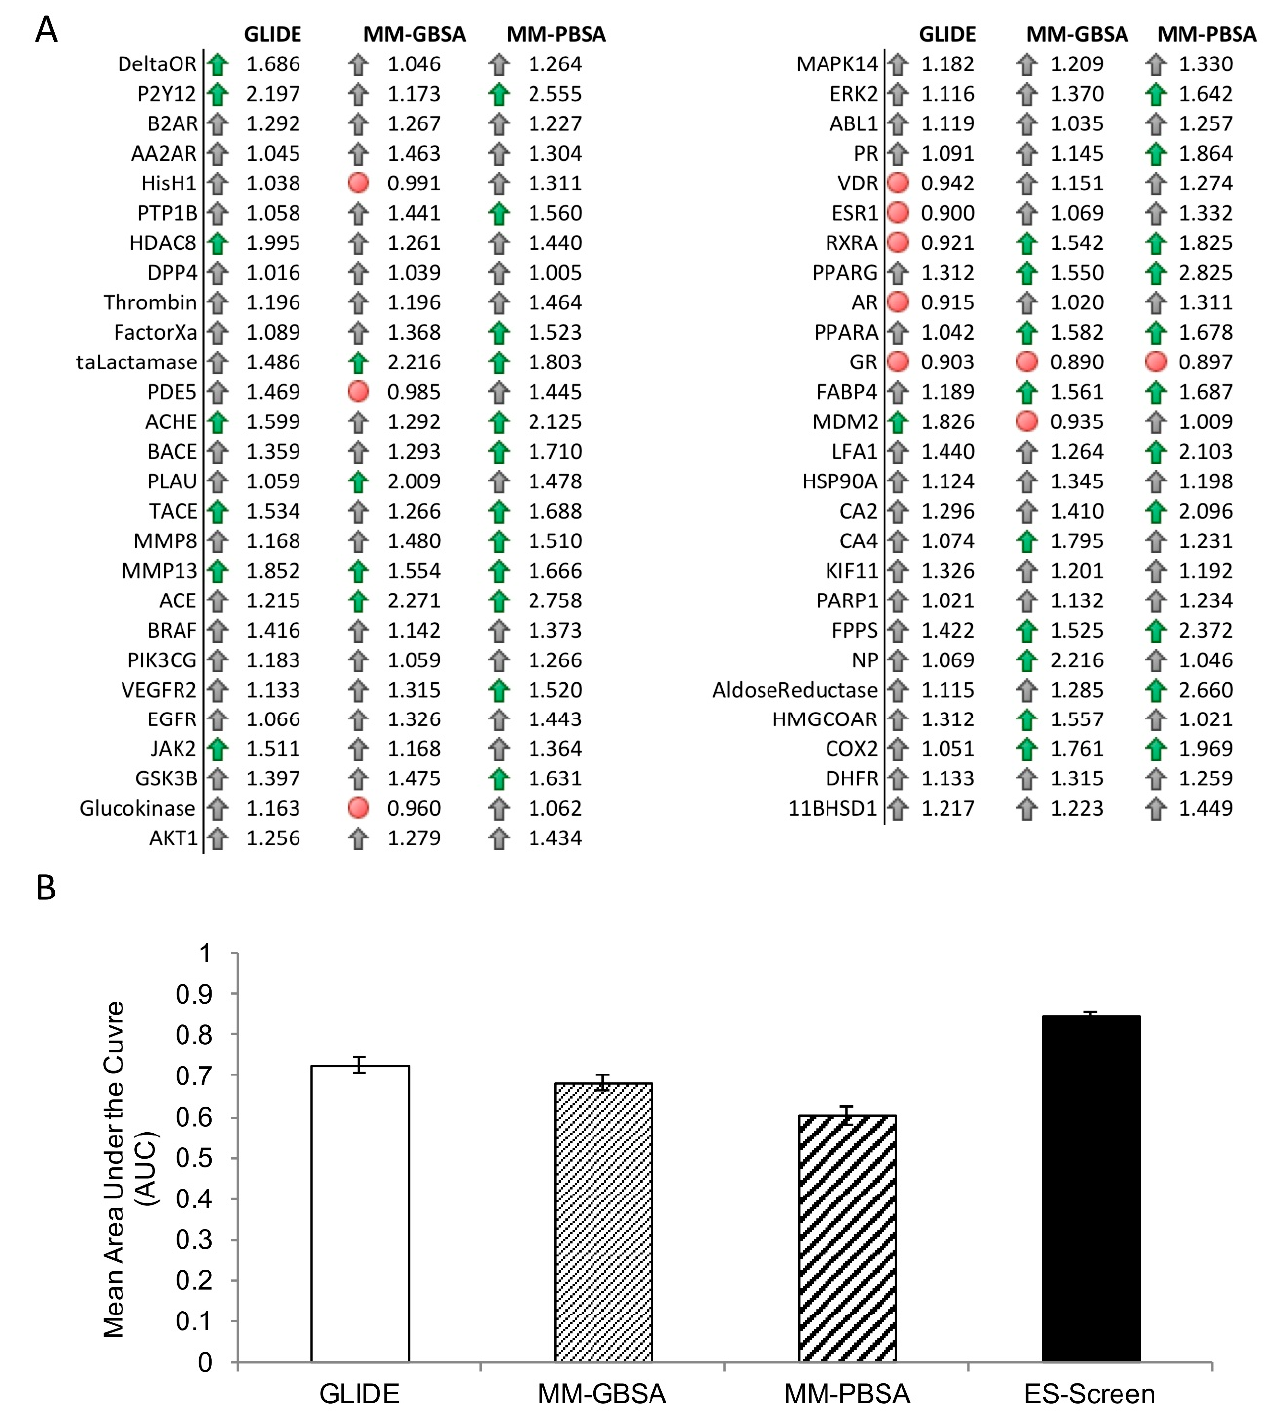
Figure 6. ( A ) Ratios of the areas under the curves (AUCs) obtained from ROC curves between ES-Screen and the indicated methods with respect to each protein target. Green arrows correspond to ES-Screen providing a >1.5-fold improvement, grey arrows correspond to ES-Screen providing <1.5-fold improvement, and red circles indicate instances where ES-Screen performed inferiorly to the respective method. ( B ) Bar graph of the mean AUCs across all protein targets with respect to each virtual screening method.